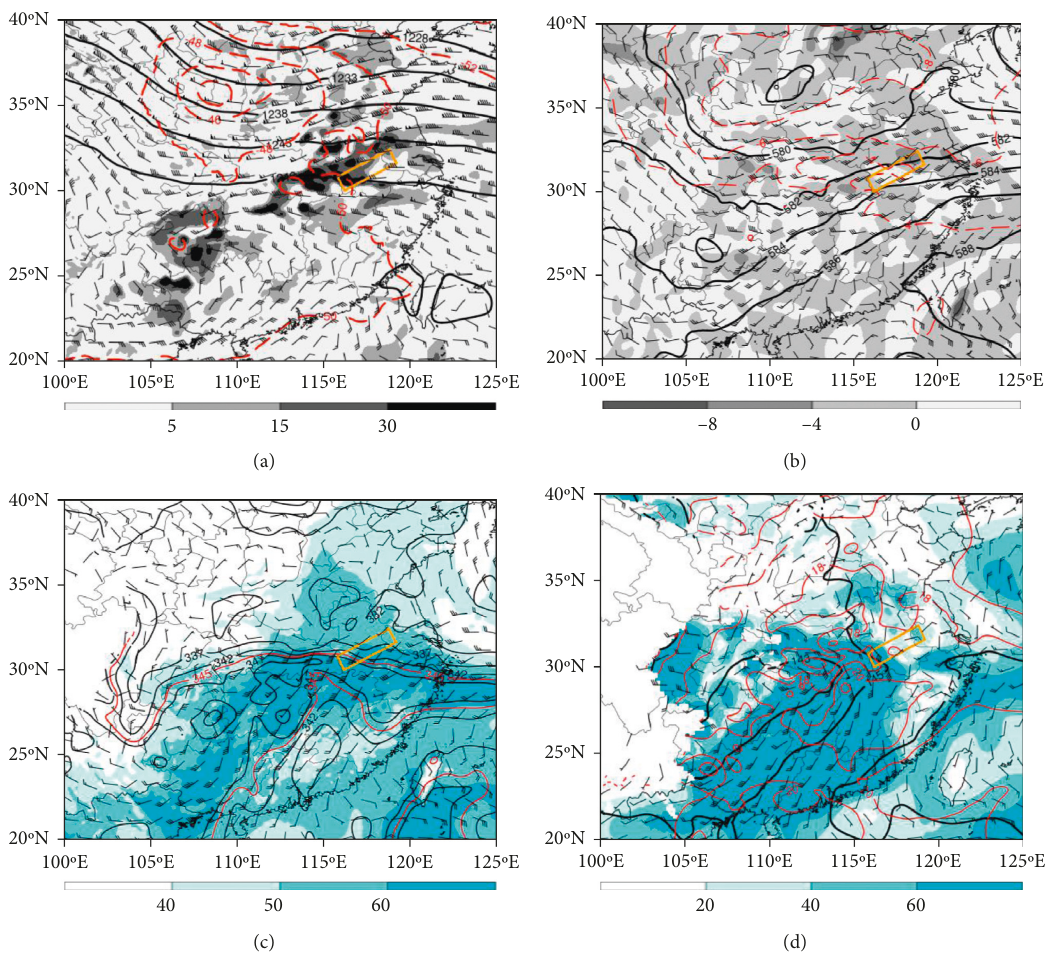
1 , the same hereafter), s · −